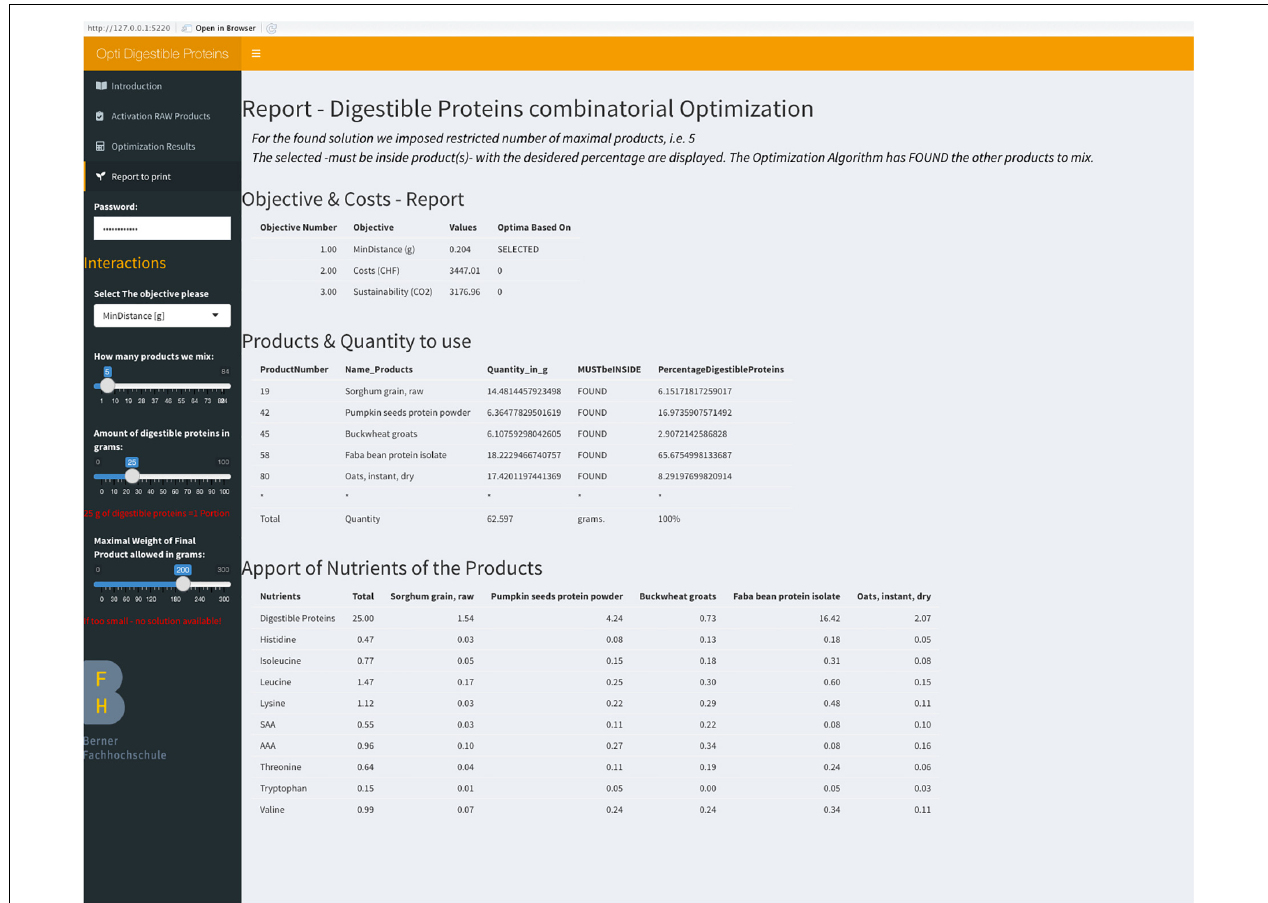
FIGURE 3 | Dashboard of NutriOpt.